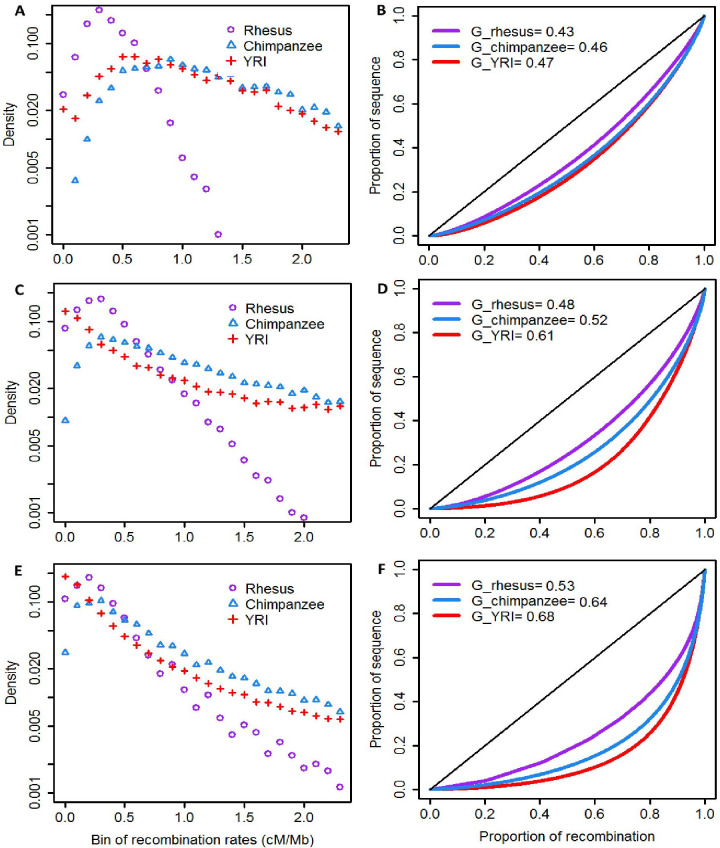
Distribution of autosomal recombination rates for different scaled windows in rhesus, chimpanzee and human (YRI) genomes.Subplots A, C and E are density of recombination rates with 1-Mb, 100Kb and 10Kb windows; subplots B, D and F present Lorenz curves for the distributions of recombination rates using 1-Mb, 100Kb and 10Kb windows. “G_rhesus”, “G_chimpanzee” and “G_YRI” are Gini coefficients for rhesus, chimpanzee and human (YRI), respectively.